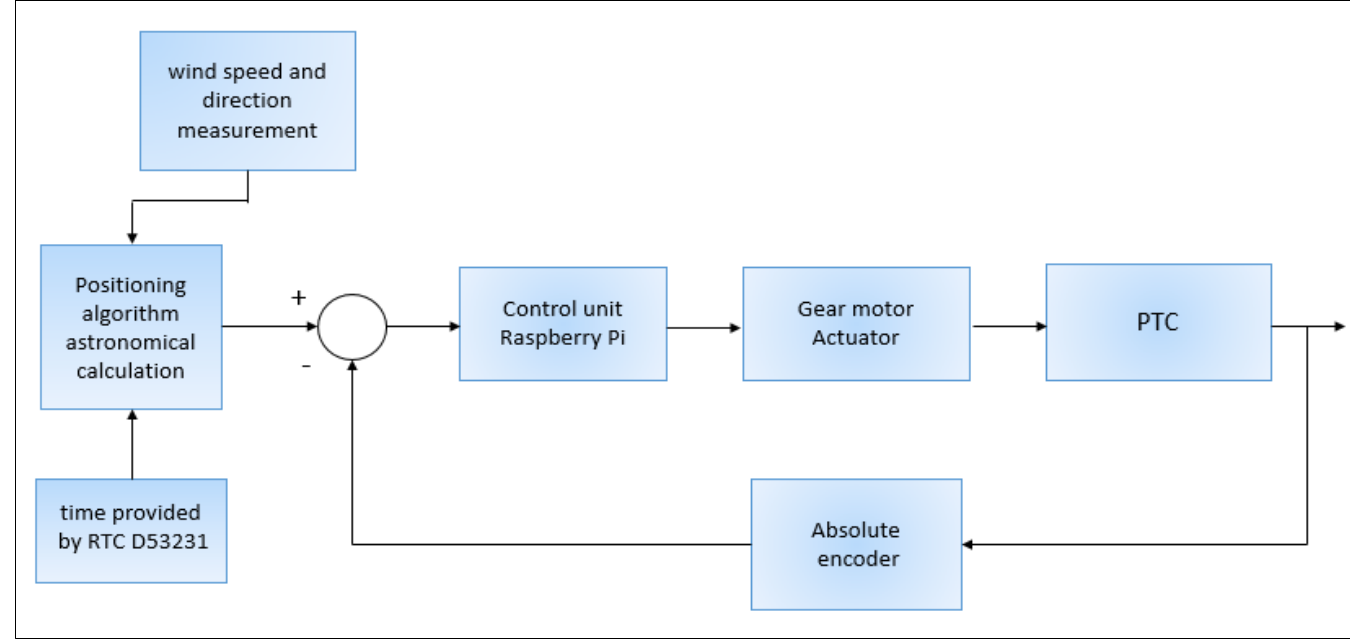
Figure 16: Position control